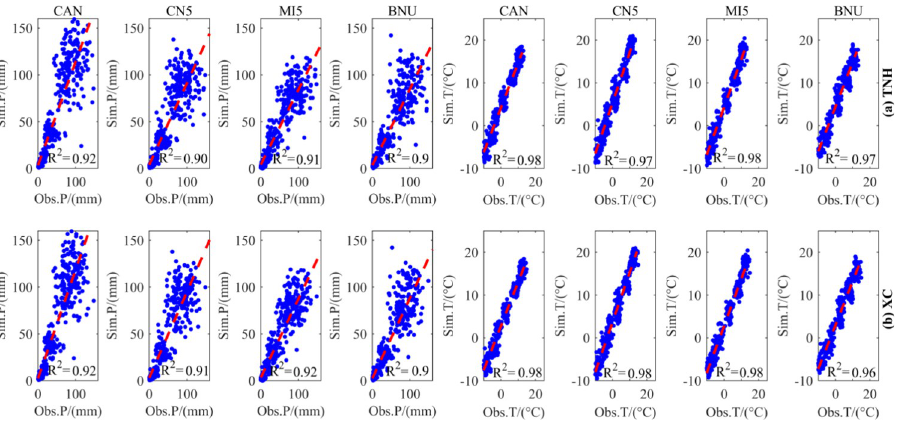
Fig 4. Accuracy evaluation of precipitation and temperature in the TNH and XC sub-basins from 1965 to 2005.